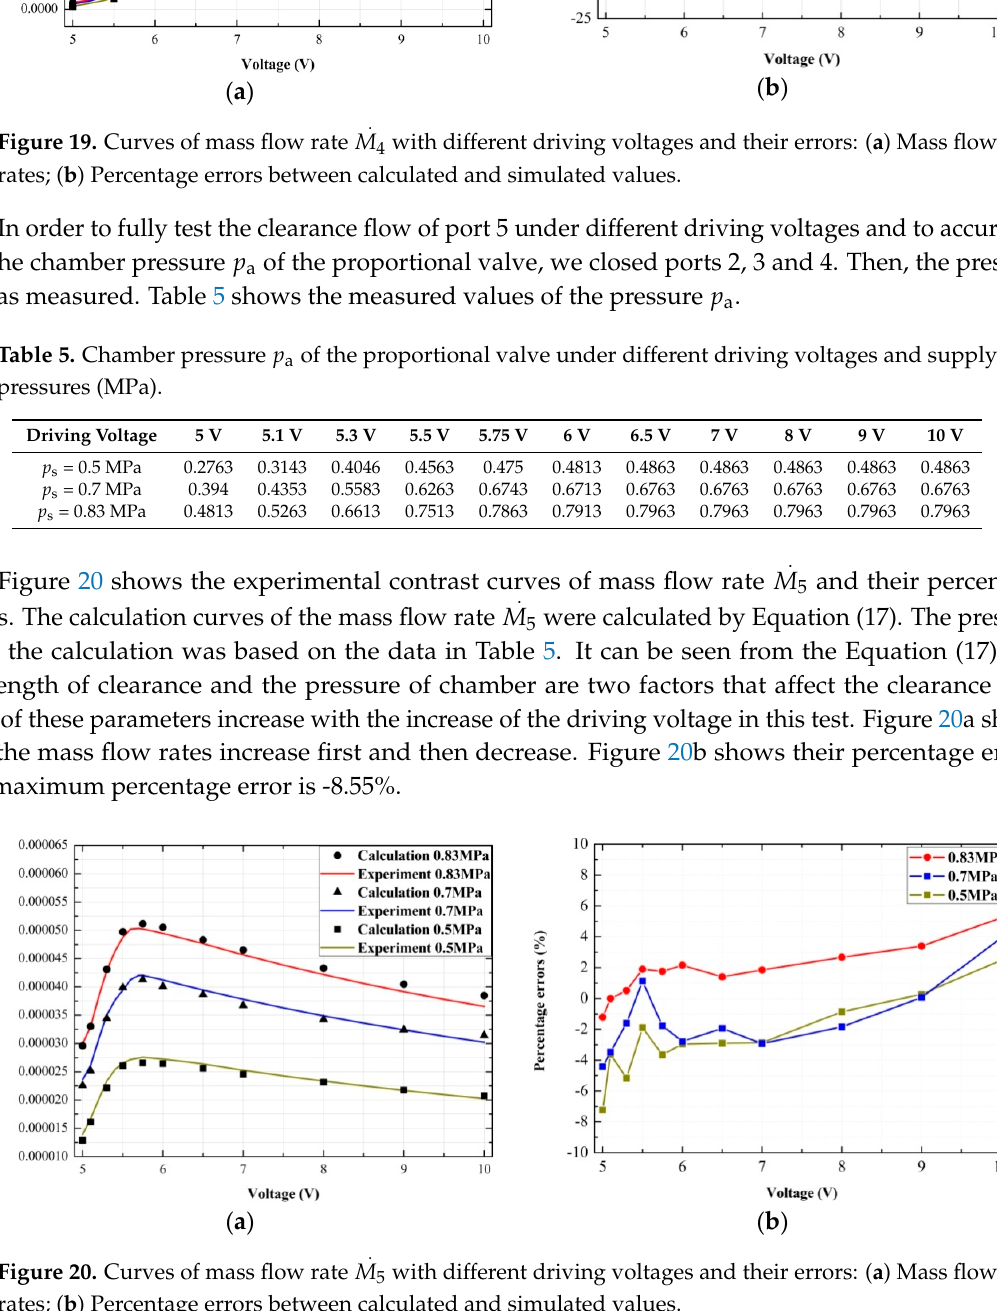
Figure 20. Curves of mass flow rates; ( b ) Percentage errors between calculated and simulated values.